Question: In one sentence, what is this figure communicating?
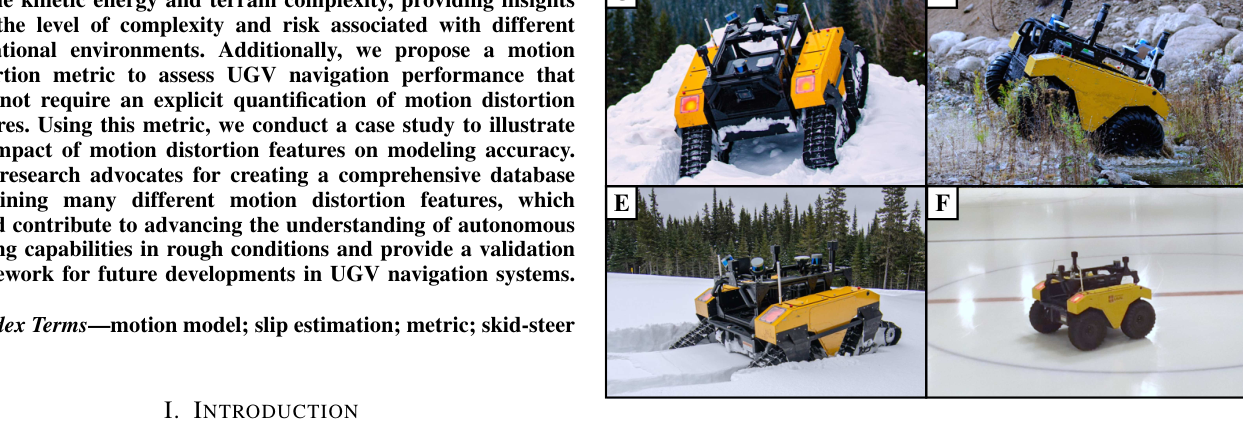
Answer: Examples of motion distortion features that affect UGV motion. Heavier vehicles with higher top speeds have more inertia (A, B). Aggressive motion leads to transitory behavior and non-linear dynamics as opposed to slower, conservative driving (A, B). Terrain steepness and roughness also lead to slippage and loss of contact between wheels and terrain (C, D). Lastly, terrain hardness and friction significantly impact vehicle motion (E, F). In F, the Warthog is navigating on a resurfaced ice rink.